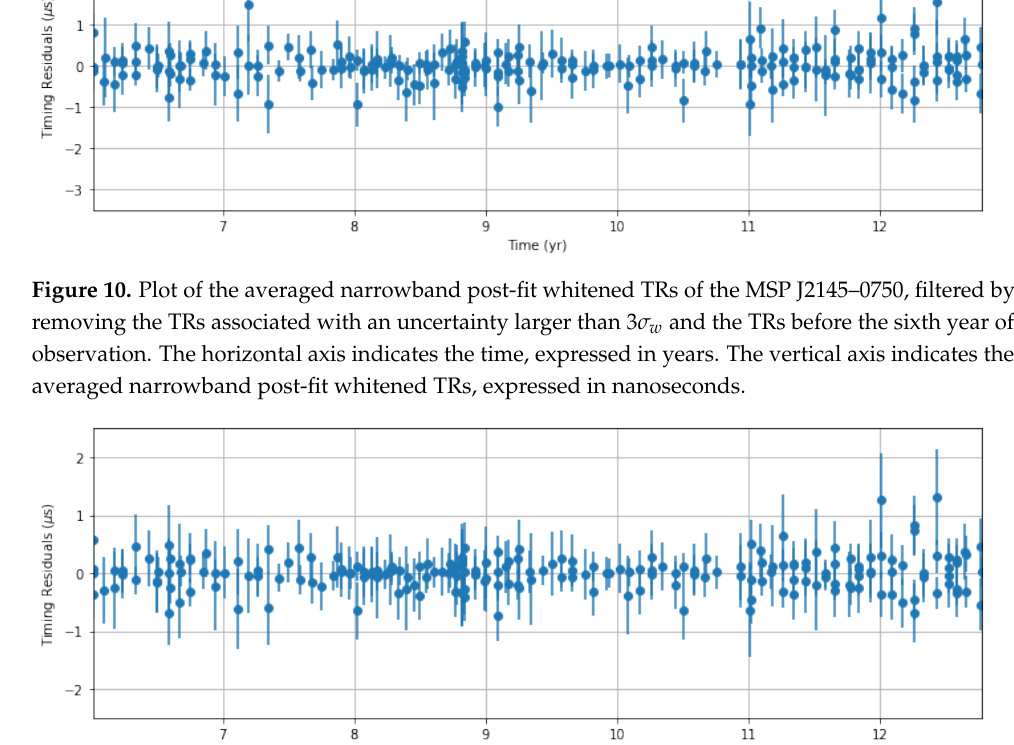
Figure 11. Plot of the wideband post-fit whitened TRs of the MSP J2145–0750, filtered by removing the TRs associated with an uncertainty larger than 3 σ w and the TRs before the sixth year of observation. The horizontal axis indicates the time, expressed in years. The vertical axis indicates the averaged narrowband post-fit whitened TRs, expressed in